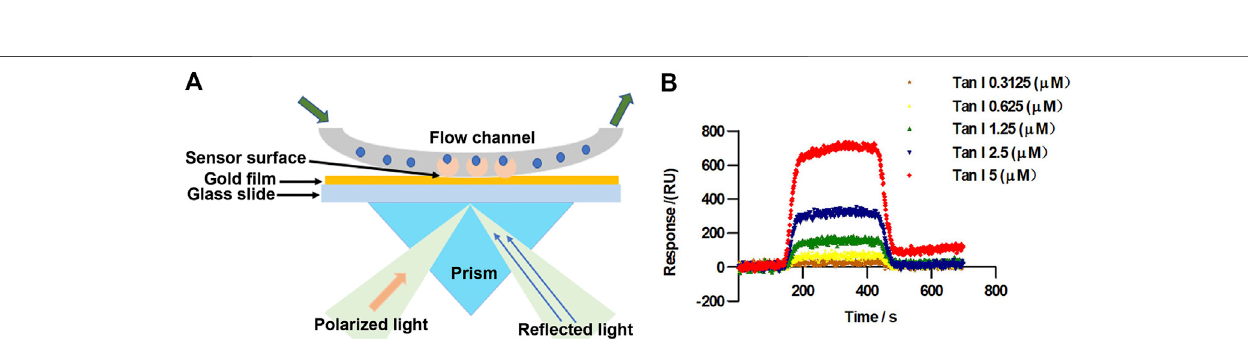
FIGURE 2 | Tan I directly targets Nrf2. (A) The principle of surface plasmon resonance (SPR) in detection of Tan I ligand-binding af fi nities for Nrf2 protein. (B) SPR fi tting curves of different concentrations of Tan I to Nrf2.